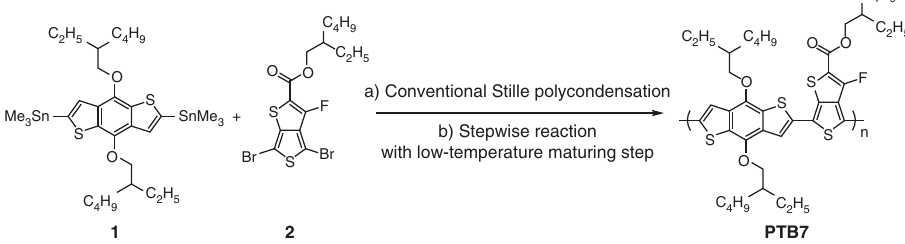
Fig. 1 Synthetic pathways for the PTB7 test-bed polymer. a Conventional Stille reaction is comprised of only steady heating procedure at 120 °C. b Stepwise Stille polycondensation in this work adopted cooling step at 60 °C after which initial heating was applied at 120 °C for fi rst 1